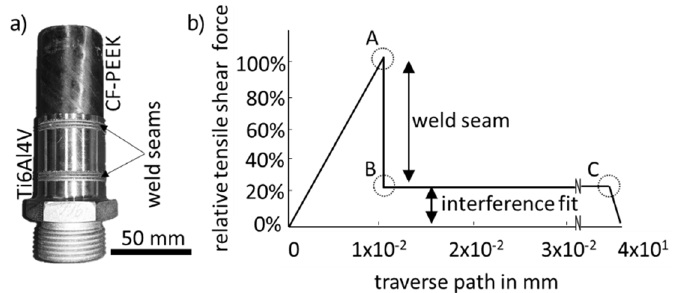
Figure 10. Ti6Al4V-fitting/CF-PEEK-tube joint, formed by orbital ultrasonic welding: ( a ) Welded sample with two weld seams, ( b ) schematic force-displacement curve.